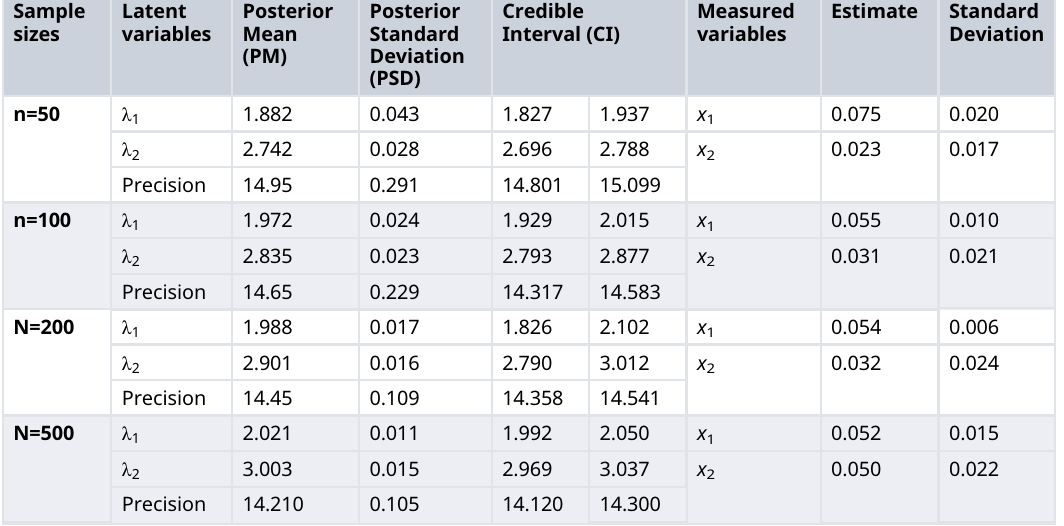
Table 3. Linear inverse form on latent variable and observed variable estimates. Sample